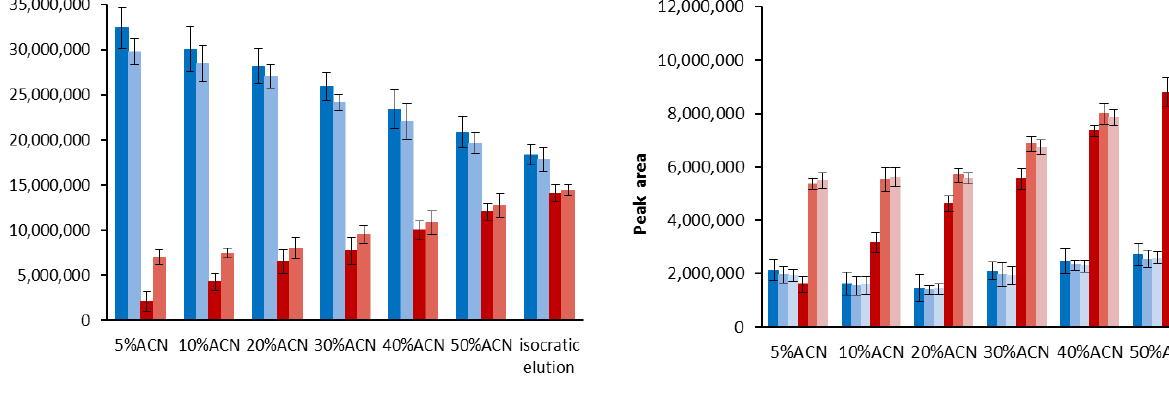
Figure 3. Comparison of the DPPH-R (brown) and DPPH-H (blue) peak areas obtained using isocratic elution mode with 60%ACN, as well as gradient modes starting with 5% ACN, 10% ACN, 30% ACN, 40% ACN, and 50% can, respectively. Dark-color columns represent gradient elution at a constant flow rate of 1 mL min − 1 , whereas light-color columns concern gradient profiles at a flow rate in the range of 0.8–2.3 mL min − 1 , ensuring a constant retention time of DPPH-H (11.38 ± 0.44 min) and DPPH-R (12.28 ± 0.53 min). The spectra were scanned in the range of 200–800 nm. The data were recorded at 330 nm ( a ) and 517 nm ( b ). The lightest columns in Figure 3b represent peak areas obtained by changing the flow rate of the mobile phase and recorded at 517 nm without UV lamp ignition. The error bars indicating SD were calculated on the basis of three independent